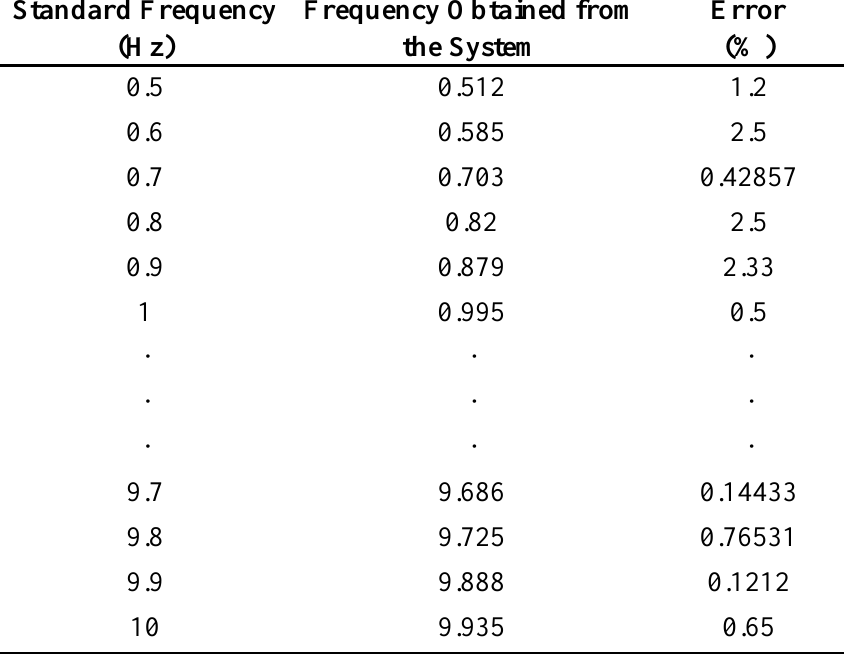
Table 1. Frequency calibration of the Parkinson’s disease measurement system from 0.5 to 10 Hz with a function generator and a